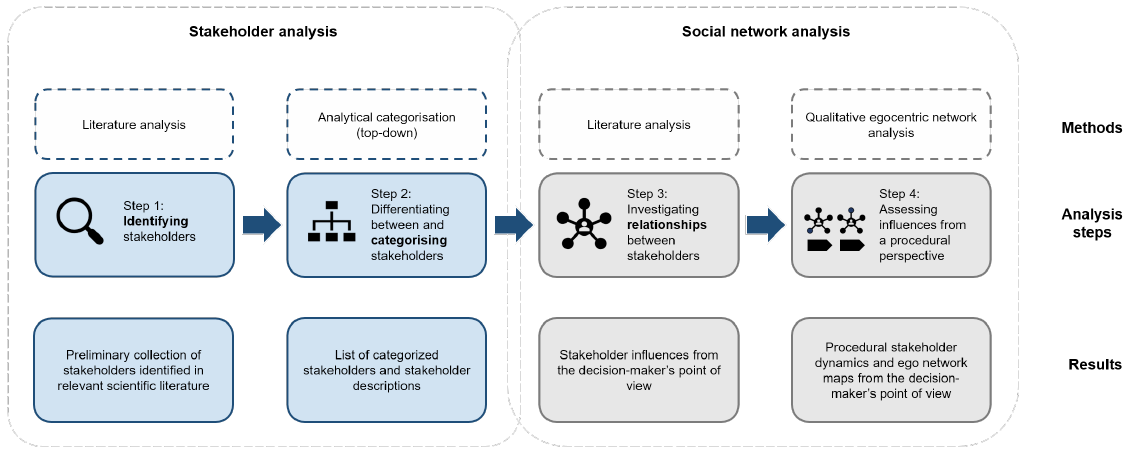
Figure 1. Analysis framework for stakeholder analysis and social network analysis to elaborate stakeholder dynamics in residential photovoltaic (PV) adoption (own